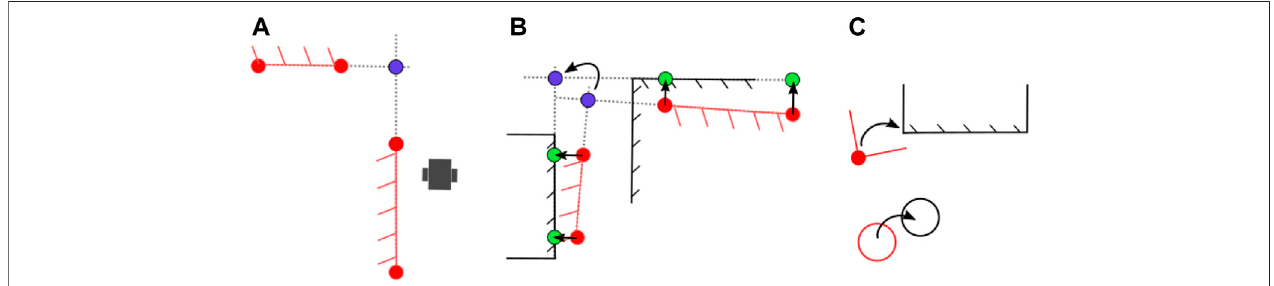
FIGURE 5 | (A) Two (partial) line segments in the local map. (B) A pre-alignment step based on the virtual intersection point (blue) allows to acquire an initial estimate.Wealsousetwopoint-correspondencesorasinglecornertoobtainthispre-alignment,dependingonwhichismostrecentlyavailable.Thesegmentendpoints